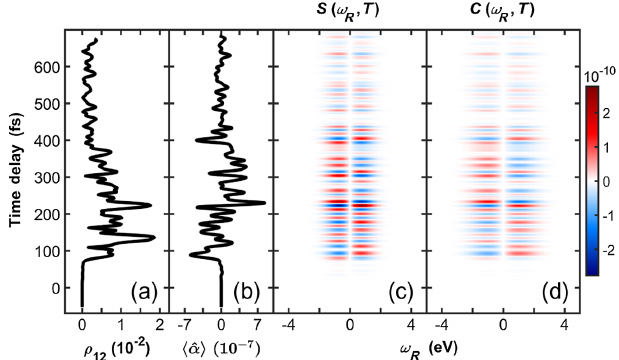
FIG. 10. STRUECARS and CTRUECARS of the uracil COIN. The effective Hamiltonian that models the nuclear WP dynamics during relaxation from the S 2 to the S 1 state has been described in Ref. [60]. The polarizability [Eq. (D7)] and the isotropic signal, averaged over the field-polarization direction, are exhibited for an 354 eV. (a) Magni- off-resonant x-ray pulse of frequency ω X ¼ tude of the coherence between the S 2 and S 1 state. After an initial free-evolution time in the S 2 state, the nuclear WP reaches the COIN, and a coherence ρ 12 emerges due to the bifurcation in the nonadiabatic passage. (b) Expectation value of the polarizability operator resulting from the dynamics in atomic units. (c) CTRUE- CARS signal according to Eq. (23) using a broadband (atto- second) and a narrow-band (femtosecond) x-ray probing field, requiring phase control. (d) STRUECARS signal according to Eqs. (39) and (40), using a single x-ray probe field with τ ¼ 0 . 93 fs ( 1 = τ ¼ 0 . 71 eV) and random